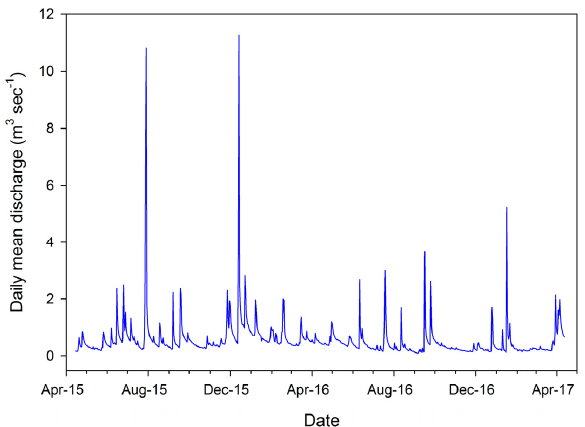
Figure 6. Study duration daily mean discharge (m 3 s − 1 ) measured at watershed outlet, Walnut Creek, Iowa. Data from USDA-ARS.